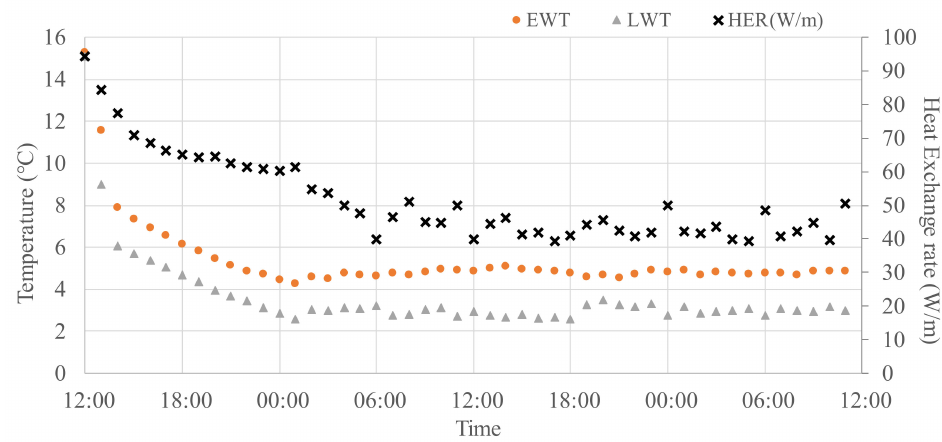
Figure 11. Fluctuation of EWT, LWT, and HER in Case